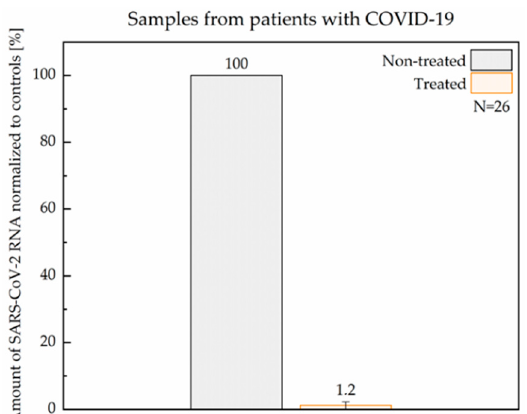
Figure 5. Reduction in SARS-CoV-2 RNA level upon treatment with ASC1R in samples from patients with COVID-19 assessed by RT-qPCR. Non-treated parallels served as controls.